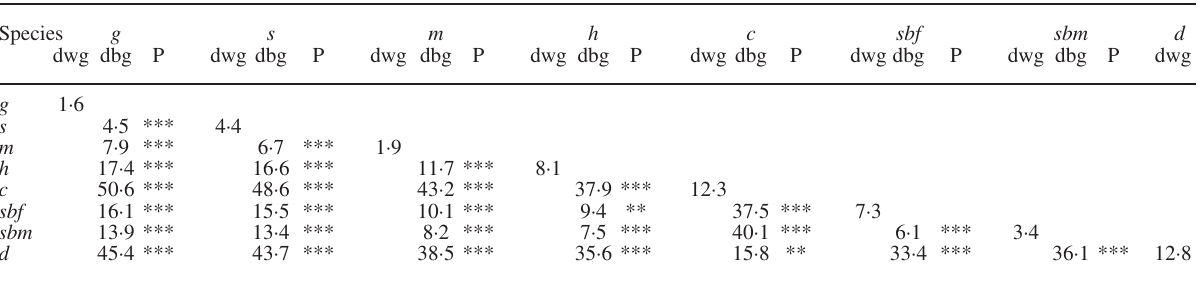
Table 5. – results of PermanoVa pairwise post-hoc comparison among species ( g : Galeus melastomus , s : Scyliorhinus canicula , m : Mustelus asterias , h : Heptranchias perlo , c : Centrophorus uyato , sbf : Squalus blainvillei female, sbm : Squalus blainvillei male, d : Dalatias licha ). euclidean distances within groups (dwg), between groups (dbg) and P -level of significance (***<0·001, **<0·01) are reported.